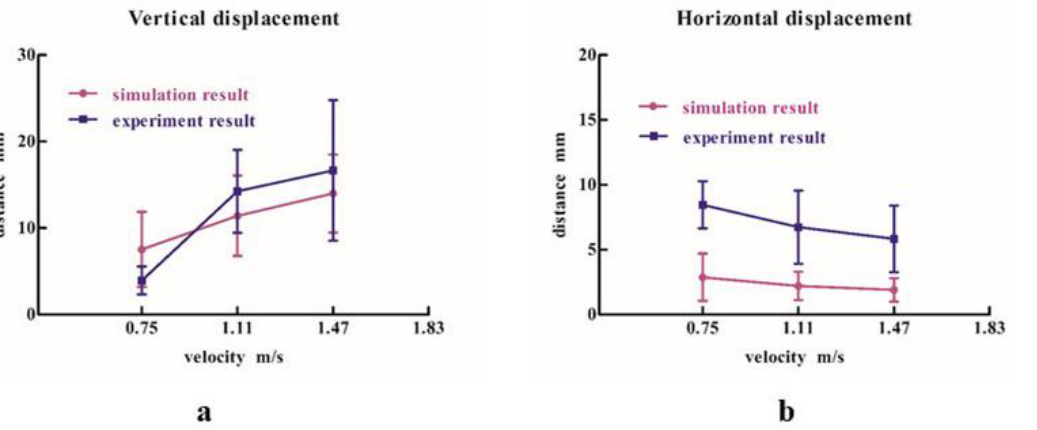
Figure 14. Comparisons of displacements of seeds after soil covering for the variety of forward velocities between simulations and experiments.